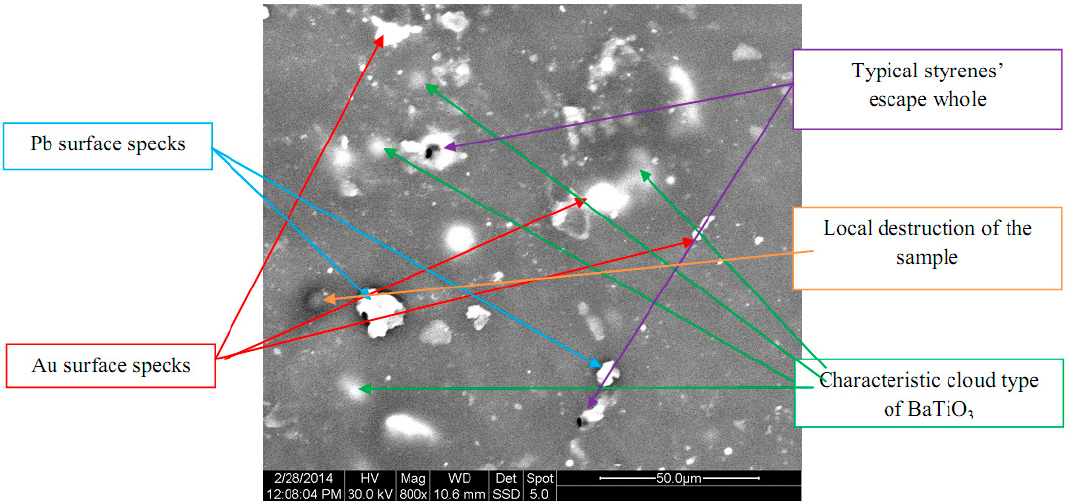
Figure 1. Scanning Electron Microscopy (SEM) image of the specimen with an M 7 A 2 PA 1 polymer matrix and 20% w/w BaTiO 3 , at a magnification of 800 times (×800).